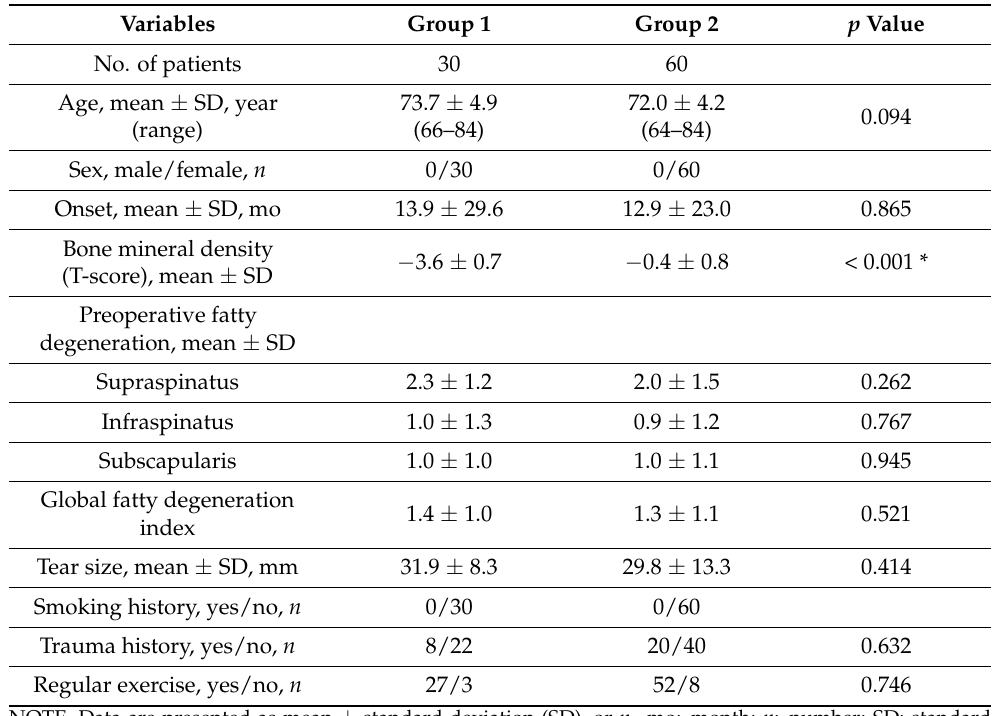
Table 1. Demographic